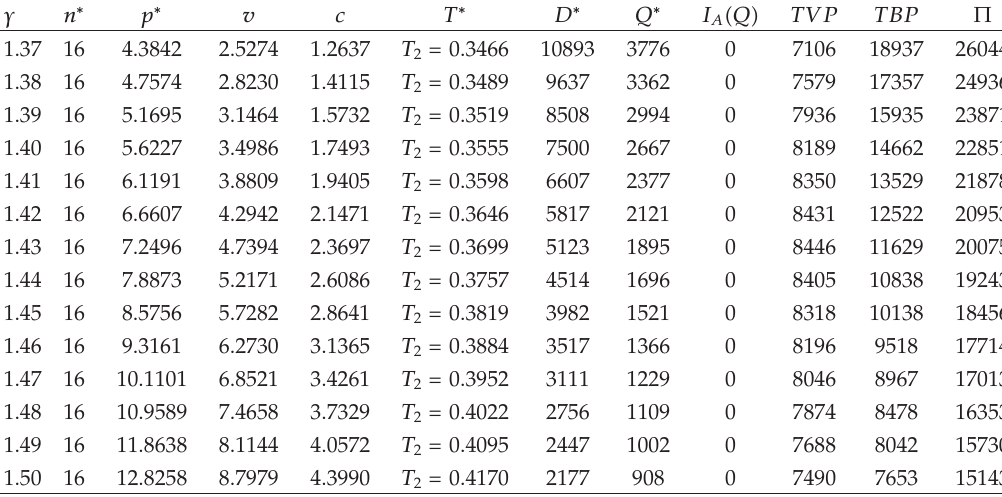
Table 5: Computation results for various values of γ (cid:3) β (cid:8) 1.52 (cid:4)